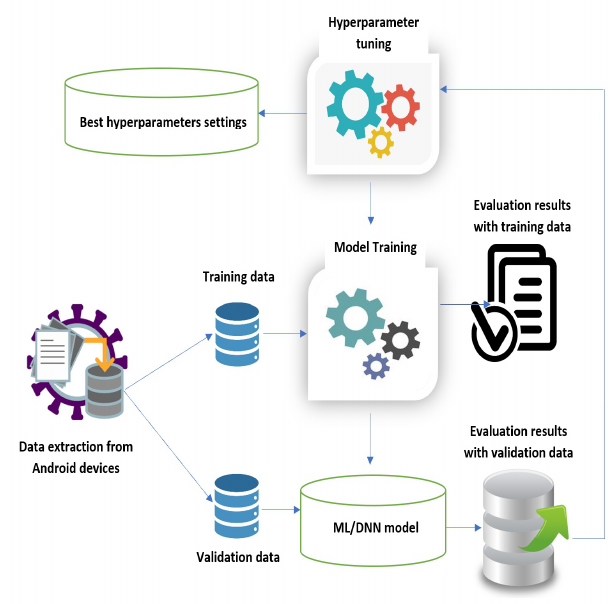
Figure 2. Abstract view of the training process and hyperparameter tuning of an ML